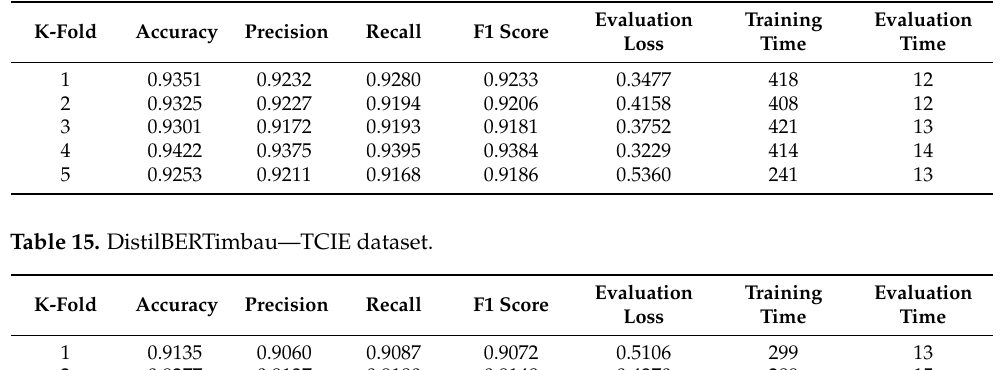
Table 14. BERTimbau—TCIE dataset.